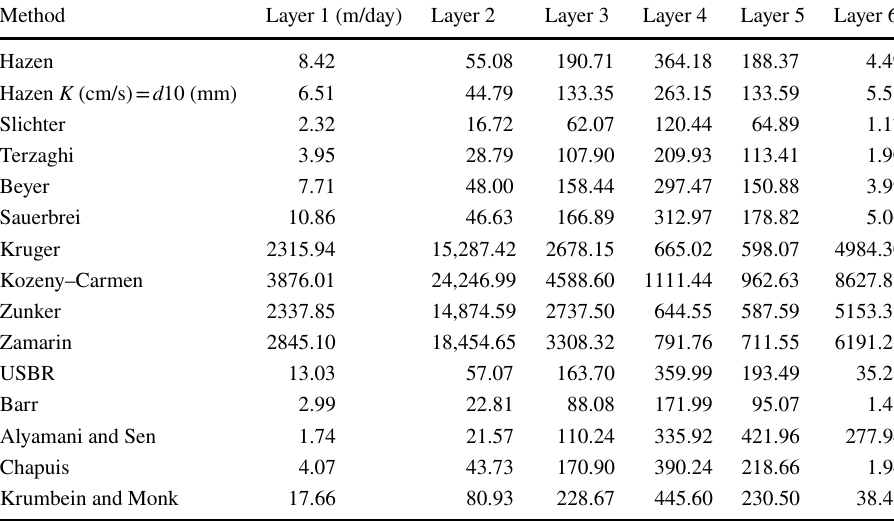
mean of Kv (in m/s) for methods used by grain-size analyses for six layers in Lower Muda Basin